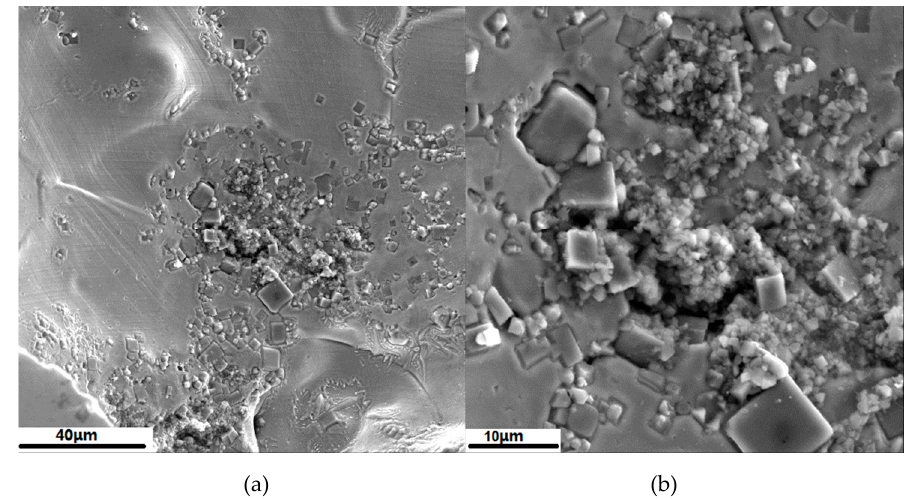
Figure 5. Aggregation of TiN inclusions in mold floater. ( b ) is the partial enlarged scale of ( a ).